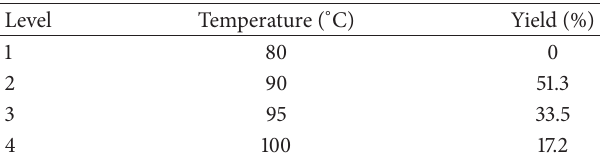
Table 6: Experimental results for synthesis of 𝛽 -(3,4-dihydrox- yphenyl)pyruvic acid at different